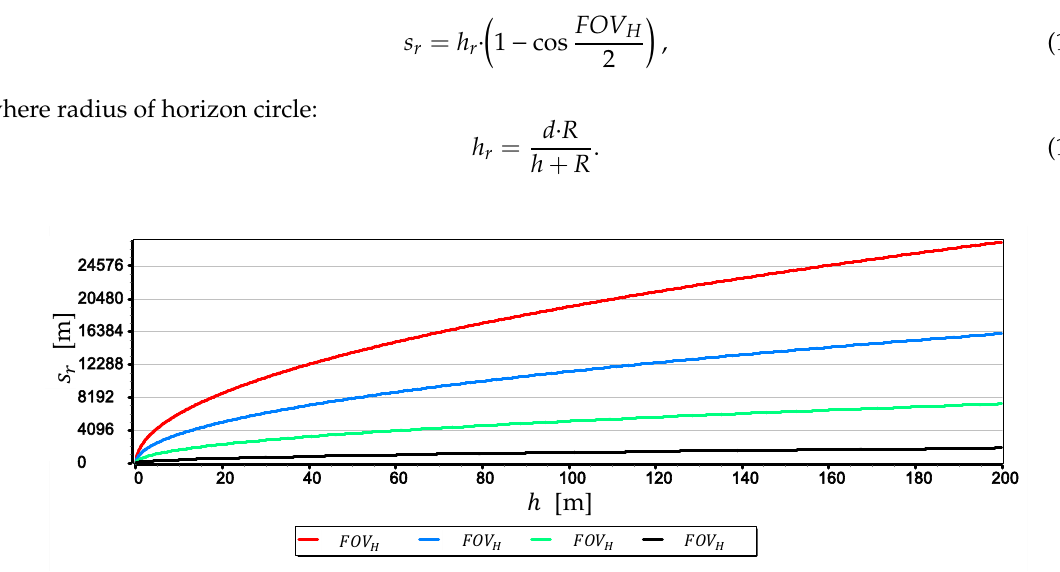
Figure 5. Horizon sagitta s r as a function of the height of the camera a.s.l. h (for FOV H equals 30 ◦ , 60 ◦ , 90 ◦ and 120 ◦ , R = 6,378,000.0 m, k = 0.16).